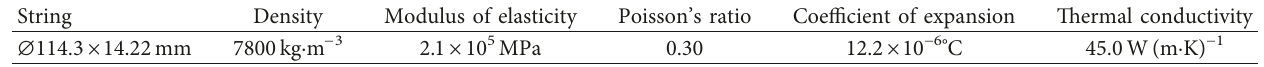
Table 1: Parameters of gas injection string of gas storage.